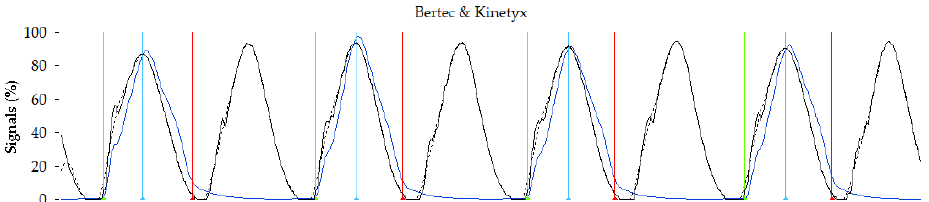
Figure 3. Normalized vGRF signal from the Bertec force-instrumented treadmill (black) and the filtered version of this signal (black dashed). Normalized pressure sum signal from the Kinetyx SI system (blue). Detection of signal onset (green), signal max (blue) and signal offset (red) for each loading cycle from a given foot from the Bertec vGRF data.